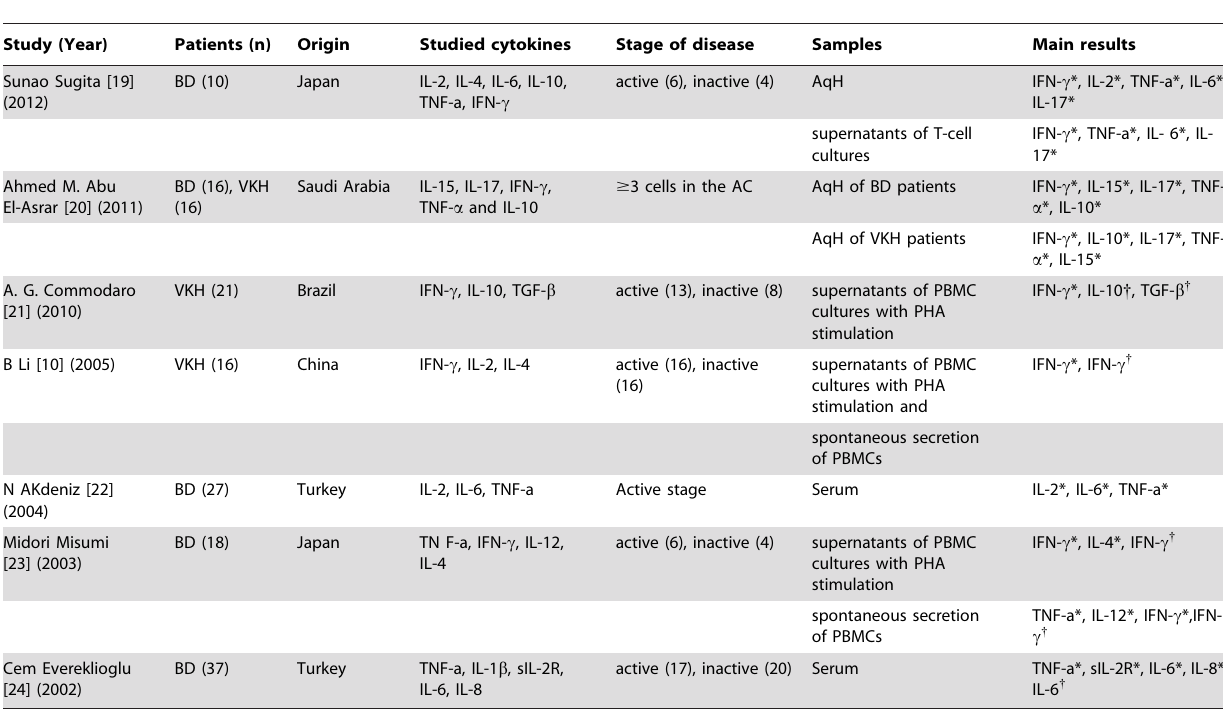
Table 3. The expression levels of cytokines in the peripheral blood and AqH samples of patients with VKH or BD, as reported in previous